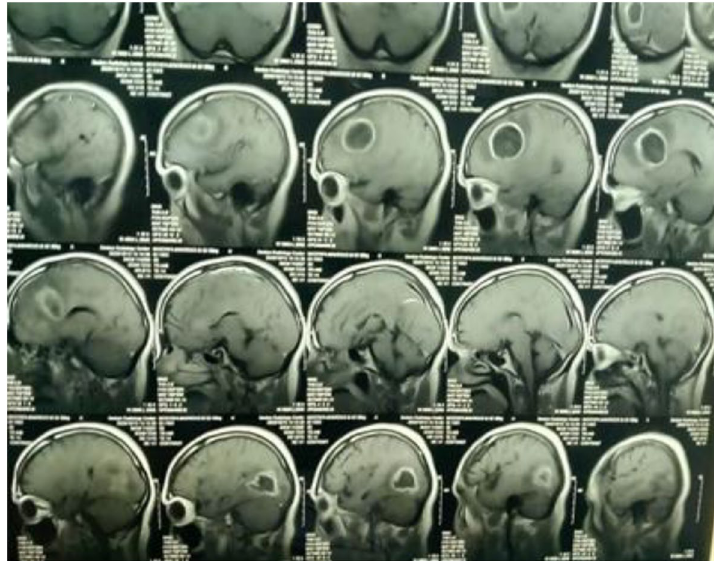
Fig. 1 MRI with contrast, sagittal section showing ring-enhancing lesions in both frontal and parietal